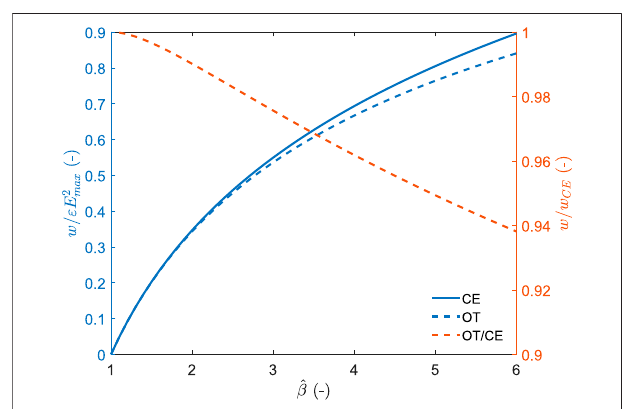
FIGURE 4 | normalised energy density harvested per cycle for the optimal triangle (OT) and constant electric fi eld (CE) cycles as a function of the capacitanceswing(blue).RelativeperformanceoftheOTcyclewithrespectto the CE cycle